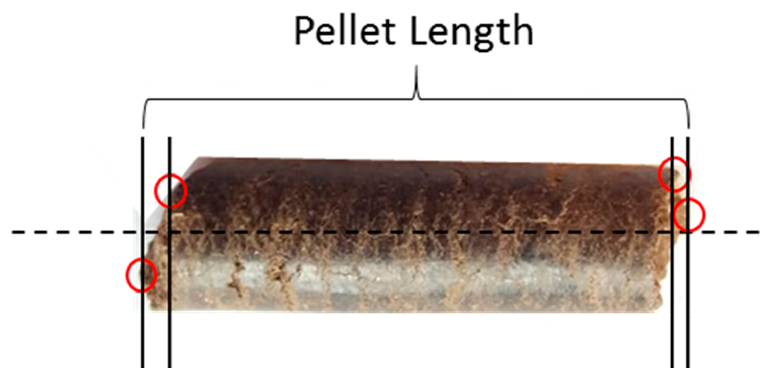
Figure 2. A two-dimensional (2D) image of a typical biomass pellet under analysis using extrema method in MATLAB (R2018b, MathWorks, Natick, MA,